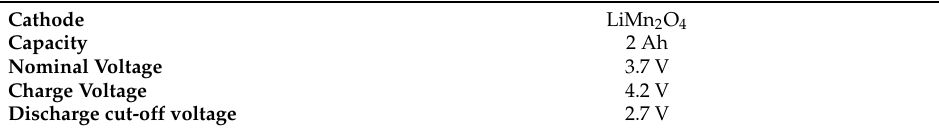
Table 2. Experimental battery information.